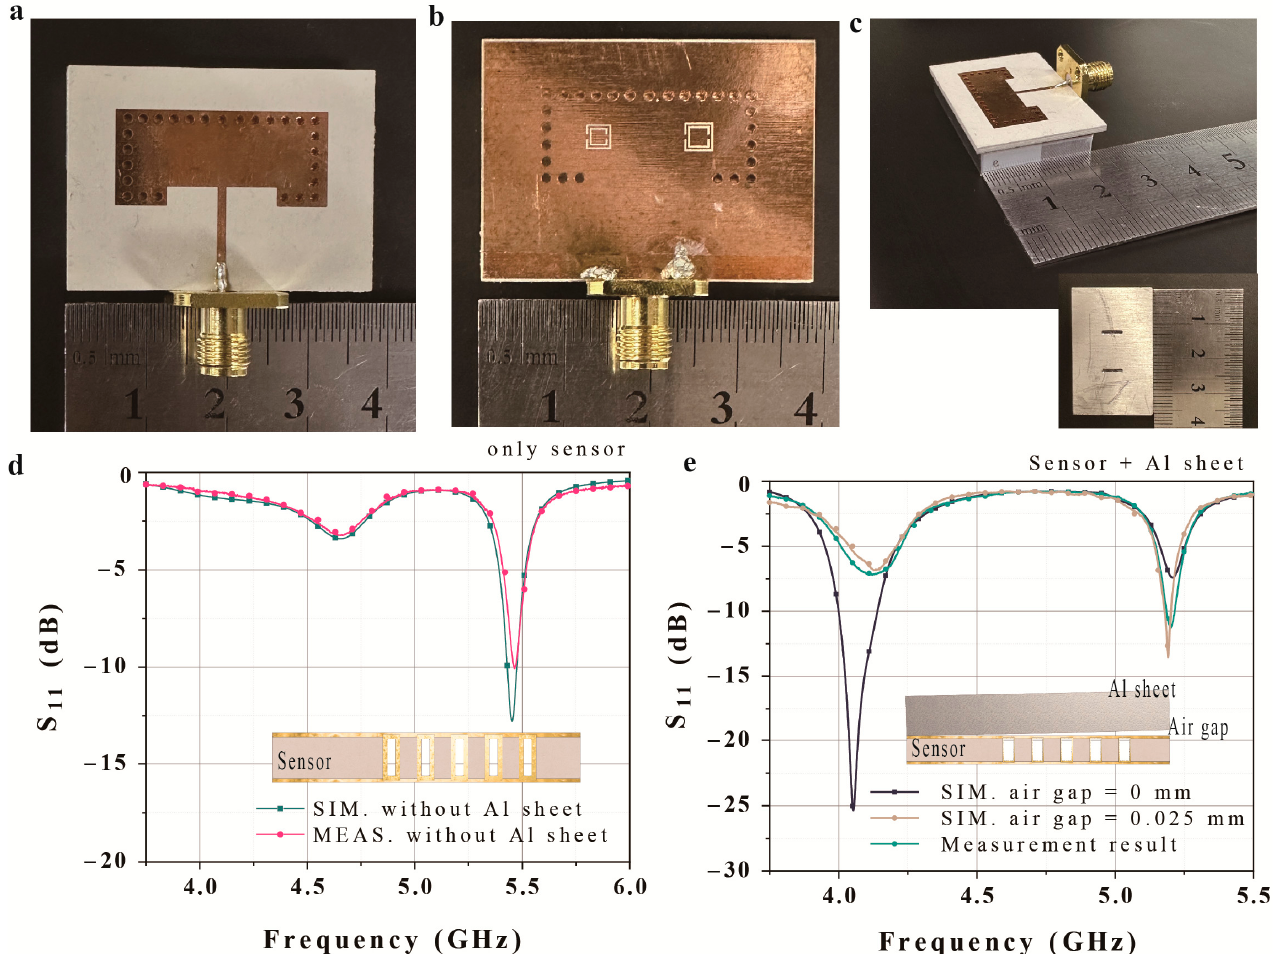
Figure 8. Fabricated prototype of the proposed dual-crack sensor: ( a ) top view, ( b ) bottom view, and ( c ) side view with the Al sheet. Simulation and measurement results for ( d ) the sensor with no Al sheet and ( e ) the sensor with an uncracked Al sheet.